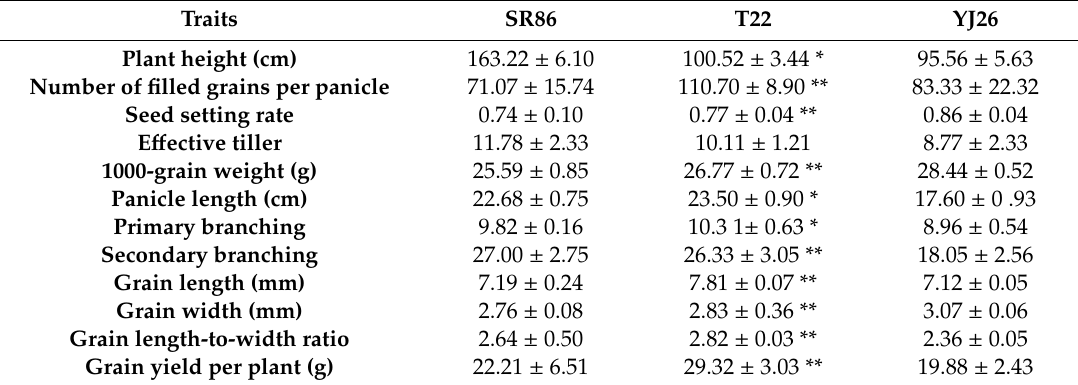
Table 3. Results of agronomic traits in infiltrated lines and two parents under normal field conditions. Traits SR86